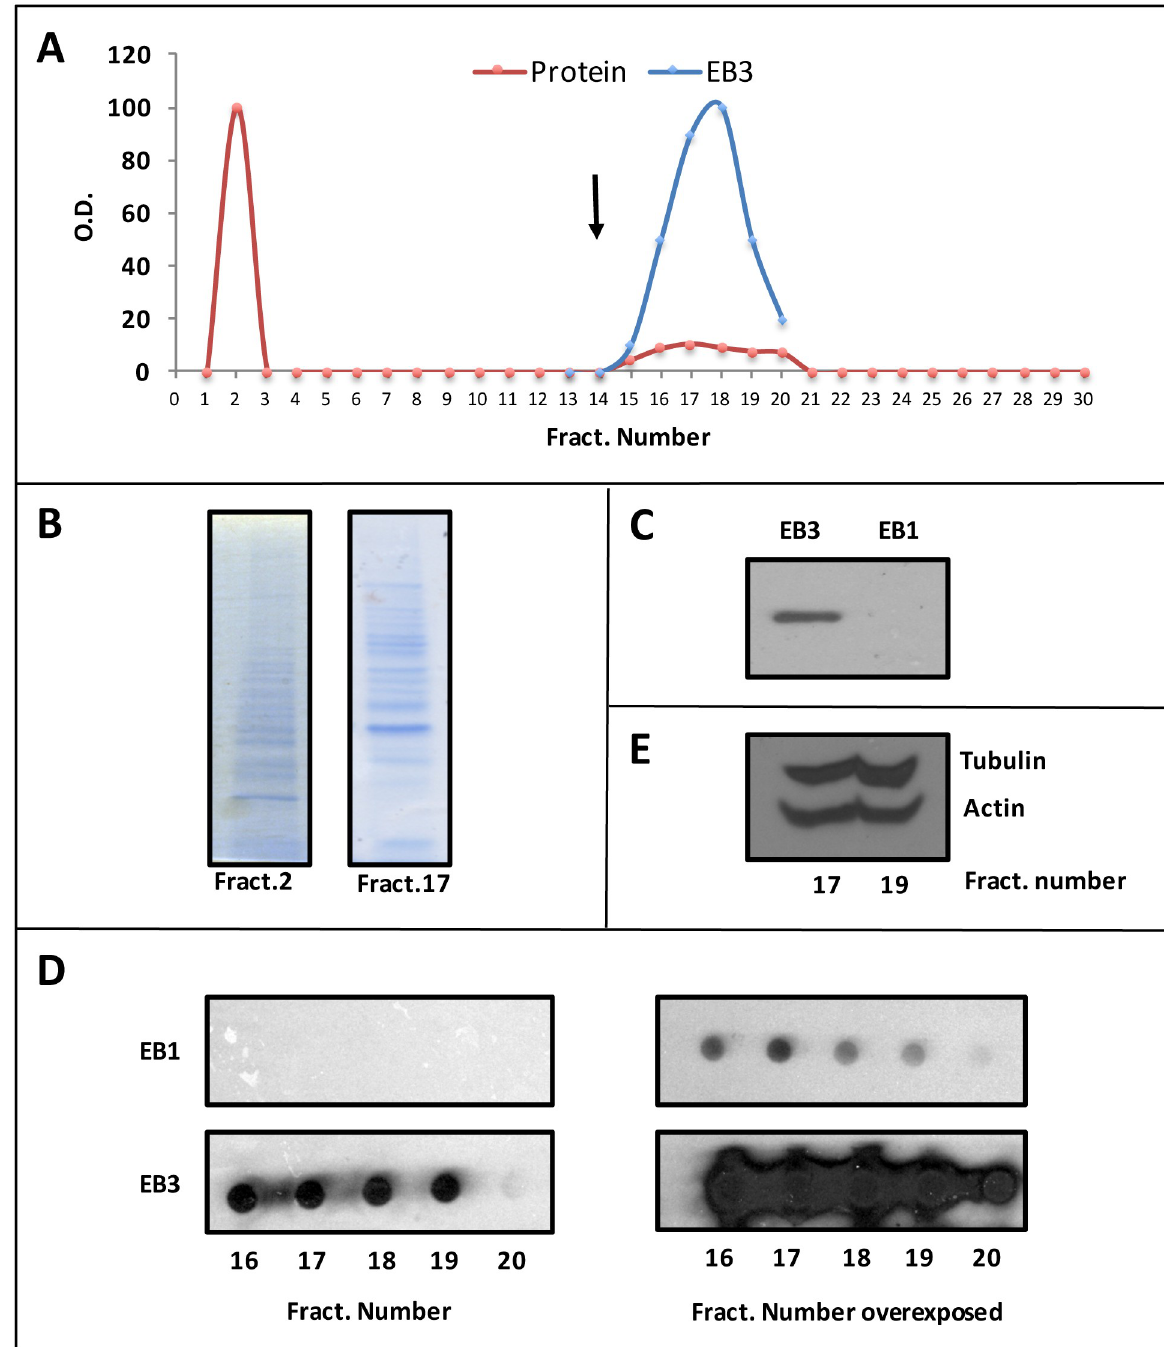
Fig 2. Binding of EB3 protein to human tau peptide 16–28. A) A human brain cell extract was chromatographed on a Sepharose column containing covalently linked a human tau peptide spanning residues 16–28. The cell extract proteins bound to the column were eluted by salt addition (see arrow). B) The unbound (fraction 2) and bound (fraction 17) proteins were characterized by gel electrophoresis. C) Western blot using specific antibodies against EB3 or EB1 proteins. D) Exposed and overexposed dot blots to analyze the presence of EB1 or EB3 proteins in the indicated eluted fractions. E) Western blot analysis using a mix of actin and tubulin antibodies tested on fractions 17 and 19.